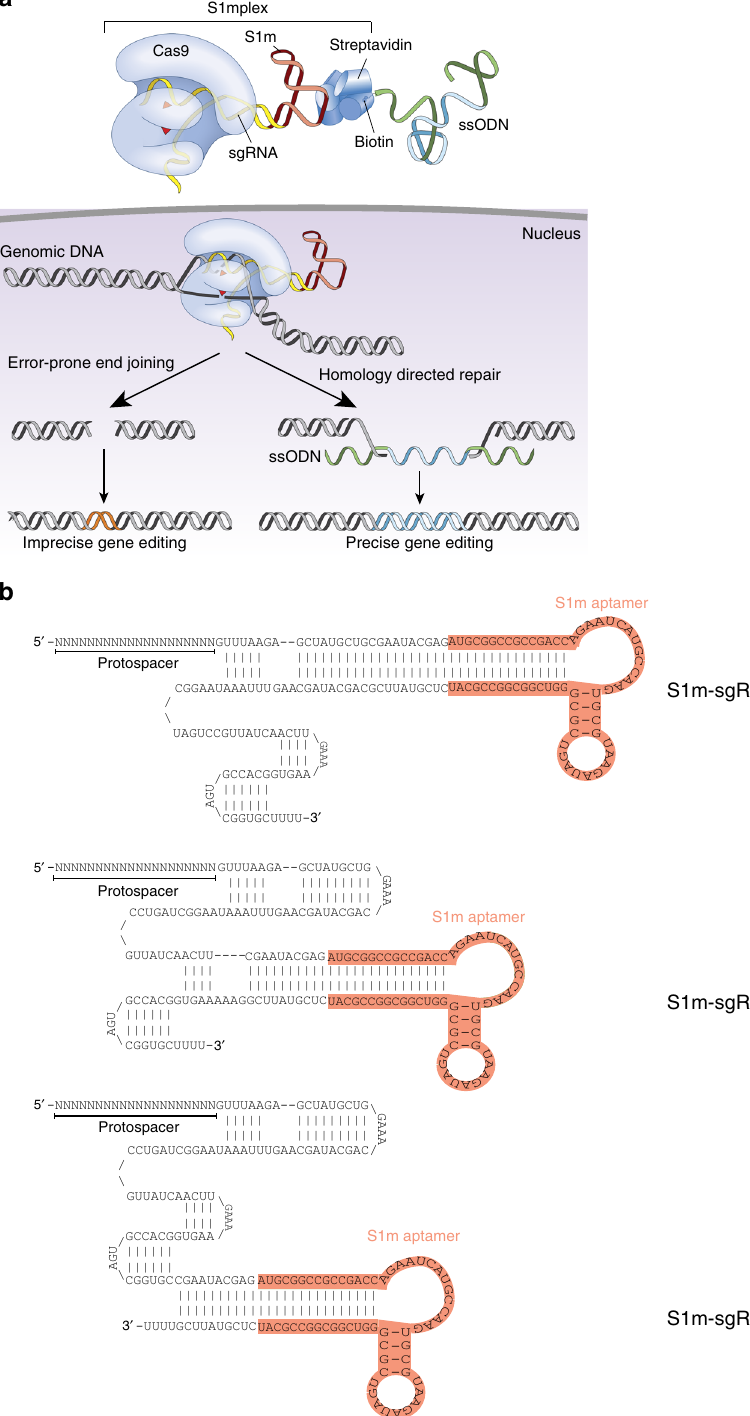
Fig. 1 Design of S1mplexes with Sp Cas9. a Schematic showing preassembled ssODN-S1mplexes that are complexes of Sp Cas9 protein, sgRNA with a S1m aptamer, streptavidin, and a single-stranded oligodeoxynucleotide (ssODN) donor template. S1m-sgRNAs add an RNA aptamer at a stem loop of the sgRNA that is capable of binding streptavidin protein. A biotin-ssODN is then added to this tertiary complex. ssODN-S1mplex particles are designed to promote homology directed repair (HDR). b Sequence and secondary structure of each S1m-sgRNA. Protospacer designates the region of the sgRNA that de fi nes the sequence to target in the human genome. S1m loop (red) binds